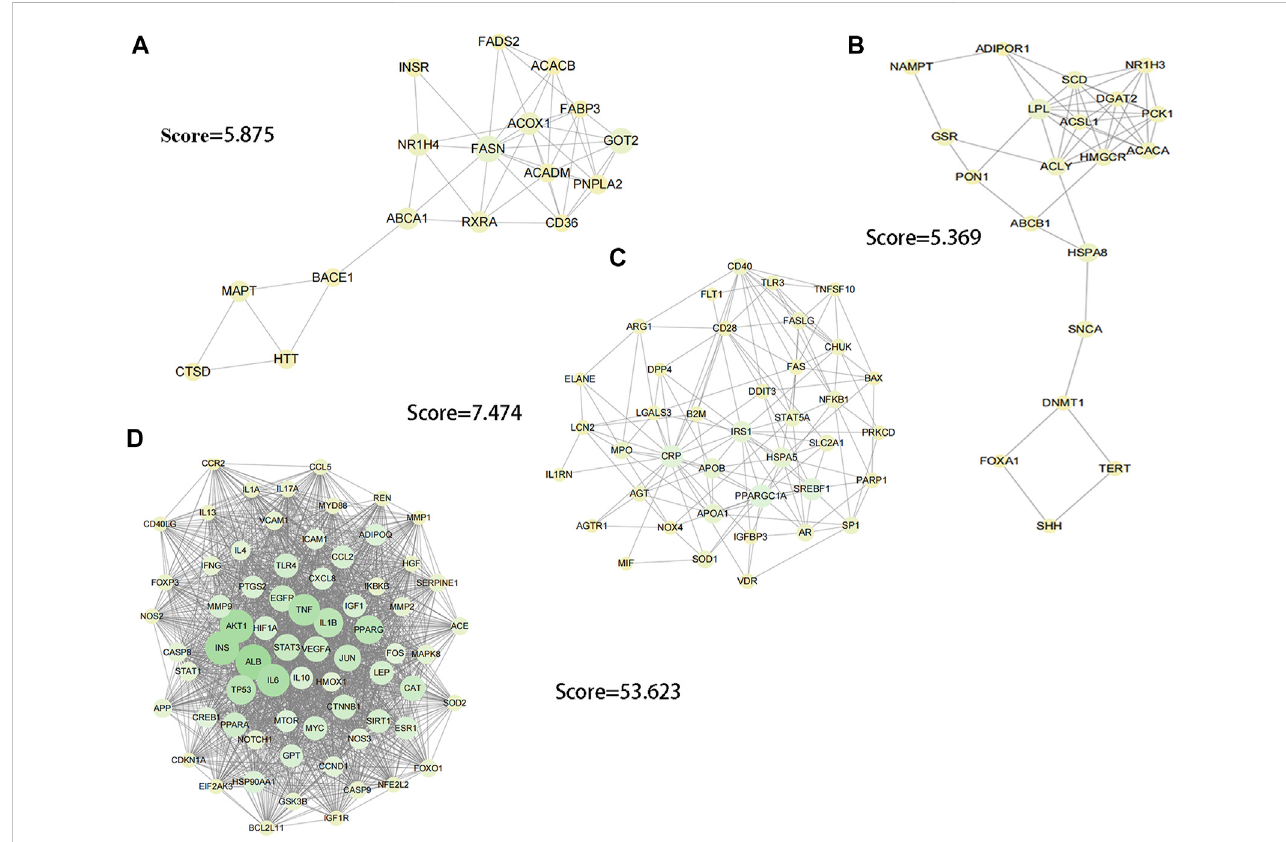
FIGURE 2 Imagevisualization ofsubnetworkswithscores > 5usingtheMCODE plug-into fi ndsubnetworks. (A) score =5.875. (B) score =5.369. (C) score=7.474. (D) score =